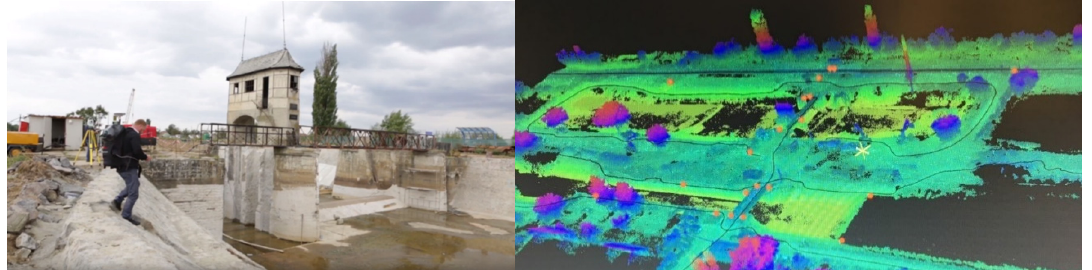
Figure 3. Scan of Sânmihaiu Romanian Lock under renovation using ScanStation Leica C10 equipment.